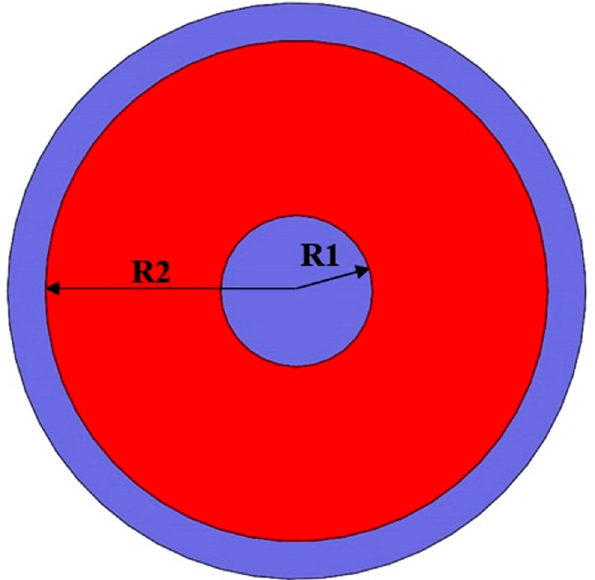
Figure 1. Schematic representation of a sputtering target. Unlike the blue zone, the red part is involved in the deposition process.